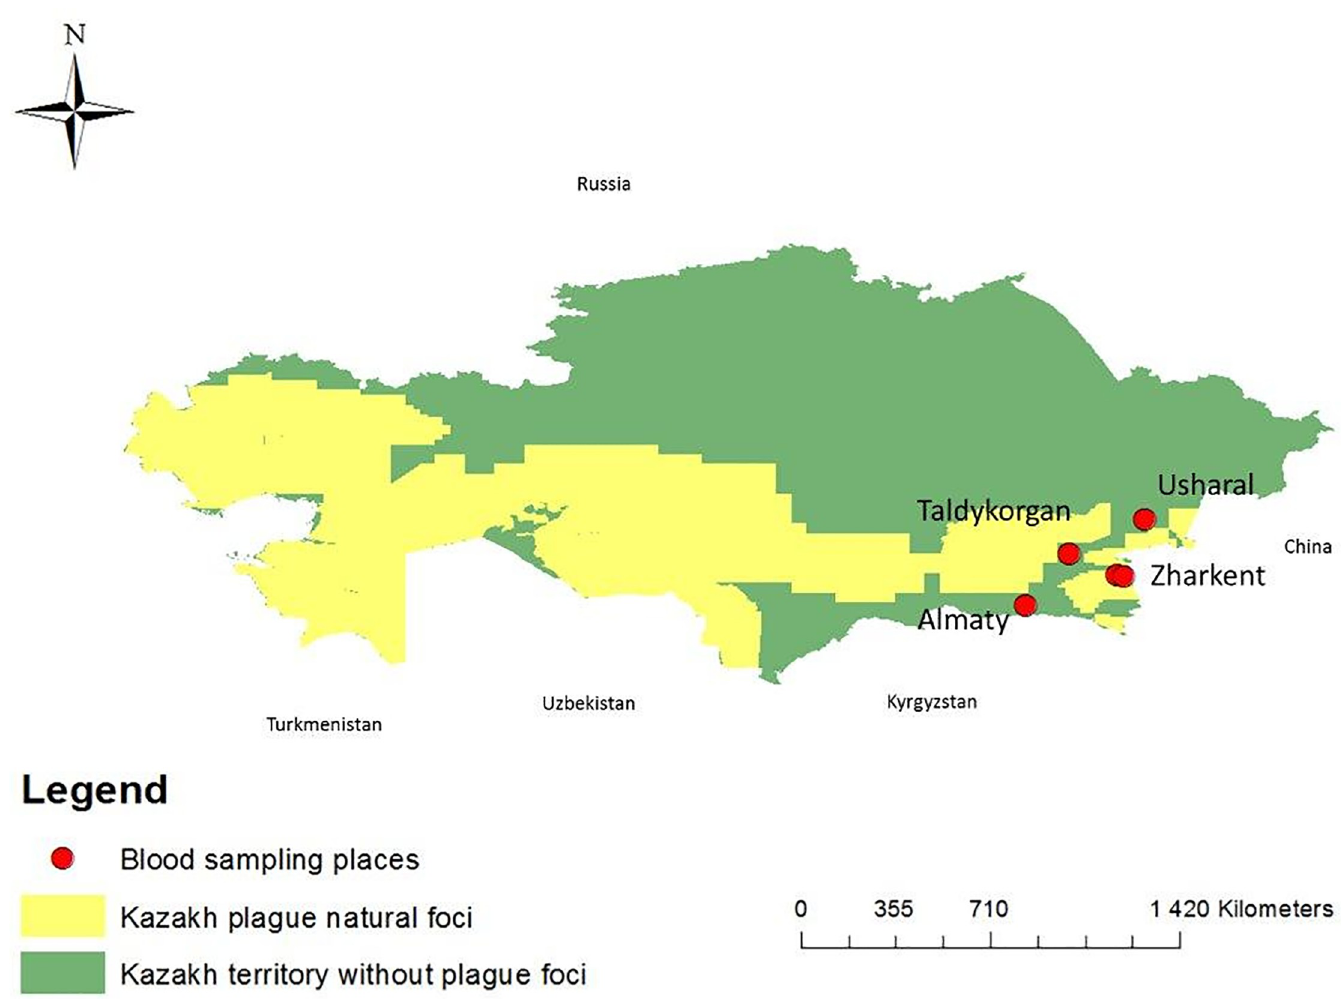
Fig 1. Natural plague foci in Kazakhstan and places where blood samples from vaccinated people were